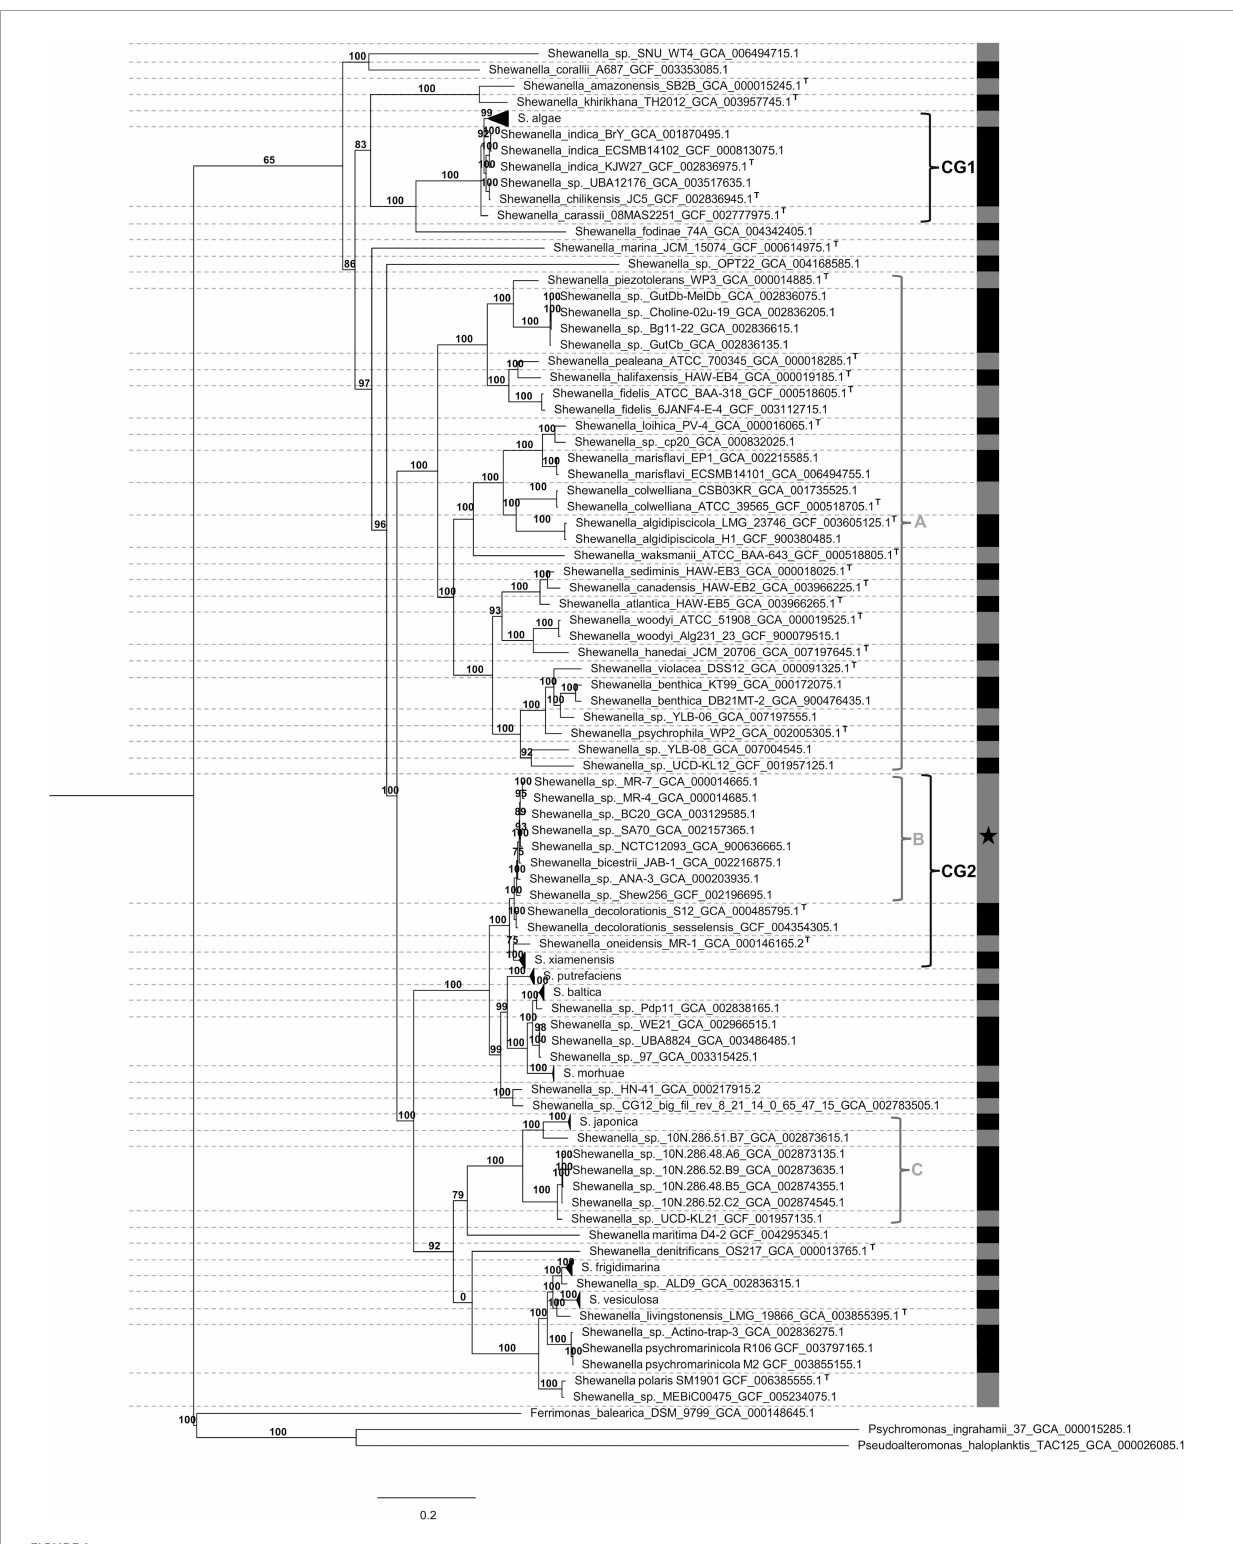
FIGURE1 Collapsed phylogenetic tree of Shewanella spp. Pairwise average nucleotide identity (ANI) was estimated for all genomes. Dotted horizontal lines (- - -) separate monophyletic groups; numbers above branches indicate bootstraps support; vertical gray and black lines show ANI values; letter T denotes type-strain isolates; black star (*) indicates species with marginal ANI values; horizontal triangles in branches depict collapsed lineages; letters A, B, and C indicate monophyletic and polyphyletic lineages; CG1 (clinical group 1) and CG2 (clinical group 2) represent monophyletic groups with 100% statistical node support containing clinical isolates; NCG (non-clinical group) encompasses remaining genomes. Alteromonadales genomes were used as